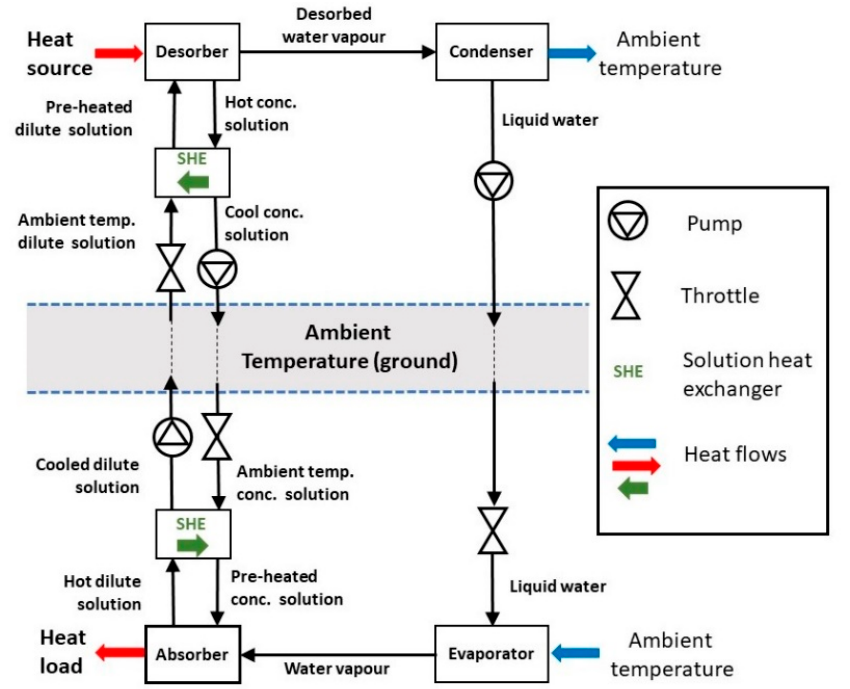
Figure 2. Proposed thermochemical heat transmission system.